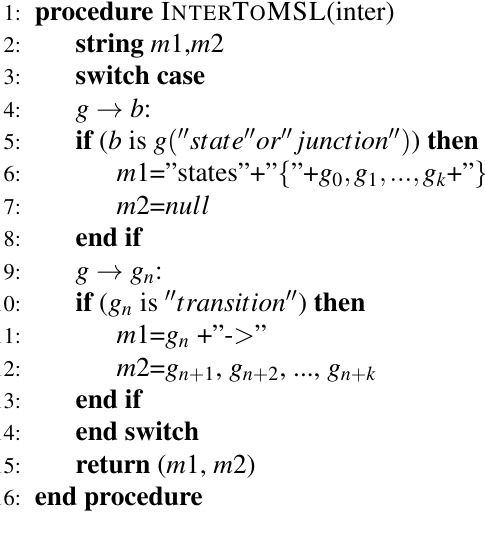
Fig. 5. Intermediate file to MSL